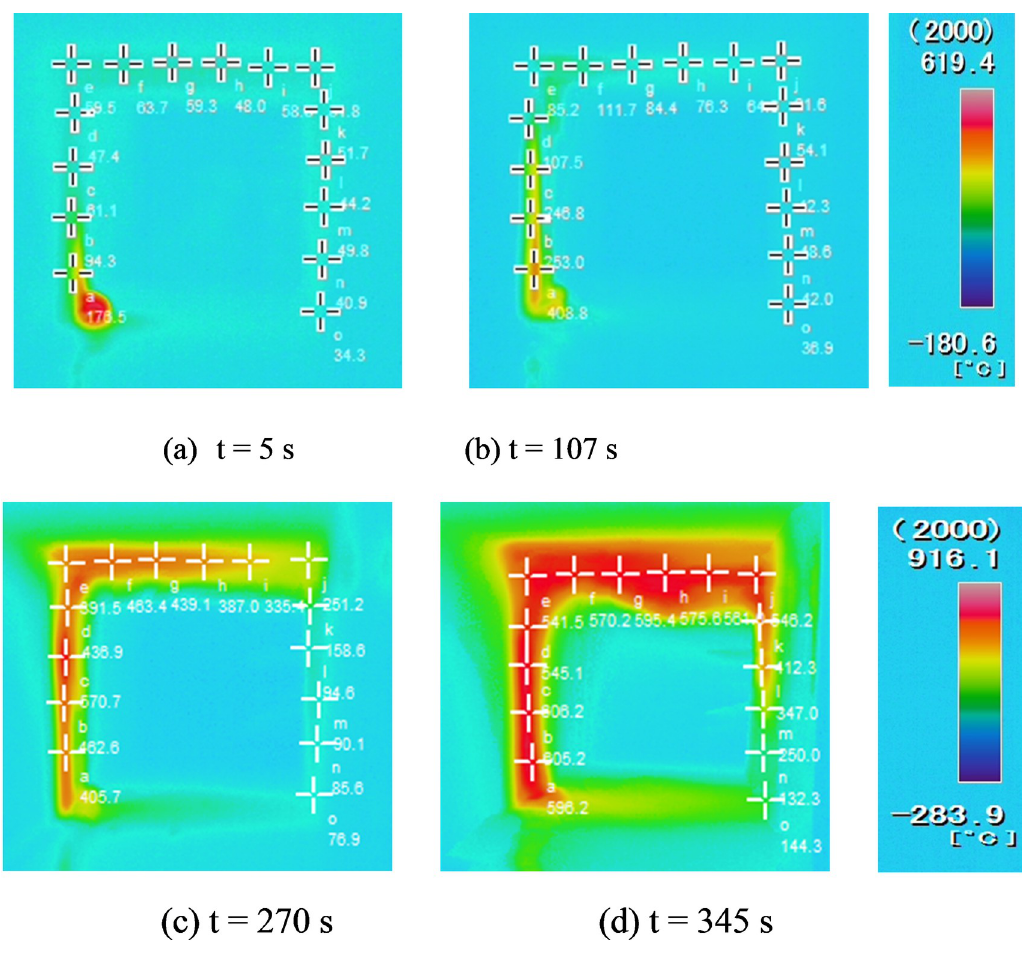
Fig 3. Flame-length changes measured with infrared